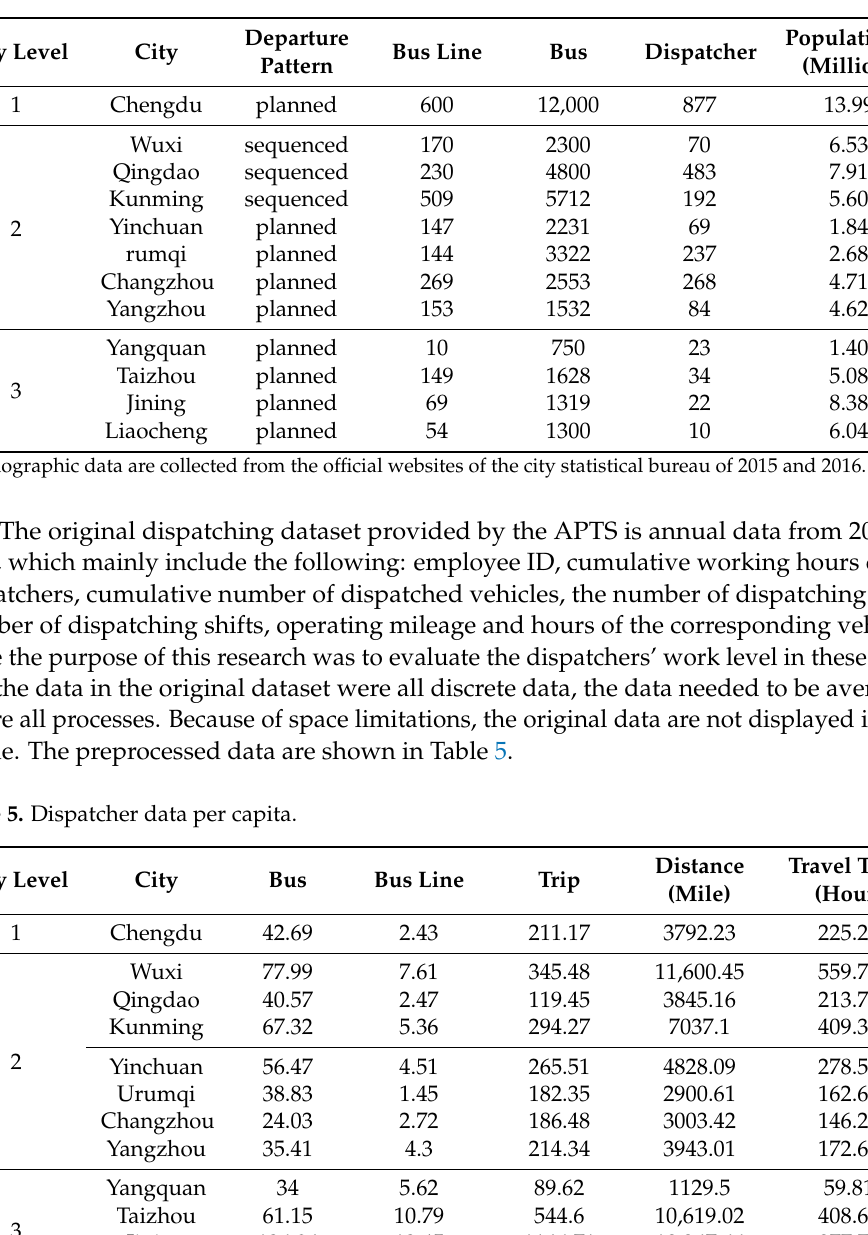
Table 4. Standards of urban grade from the perspective of public transport.